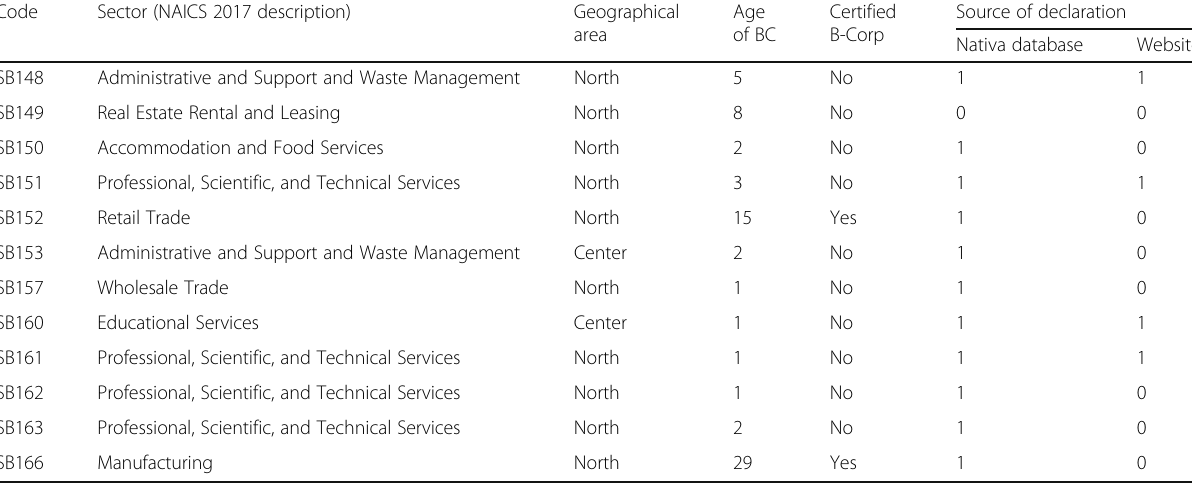
Table 1 Sample of analysis and main characteristics of BCs (Continued) Code